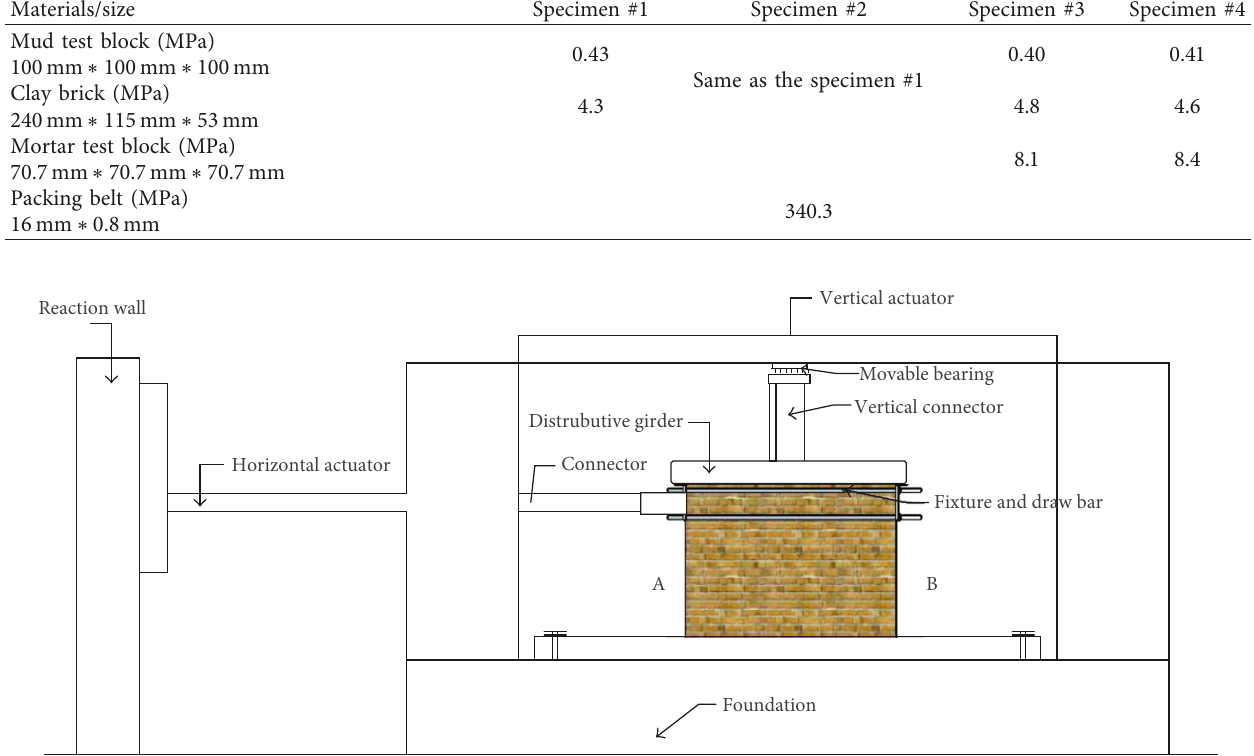
Figure 2: Diagram of experimental